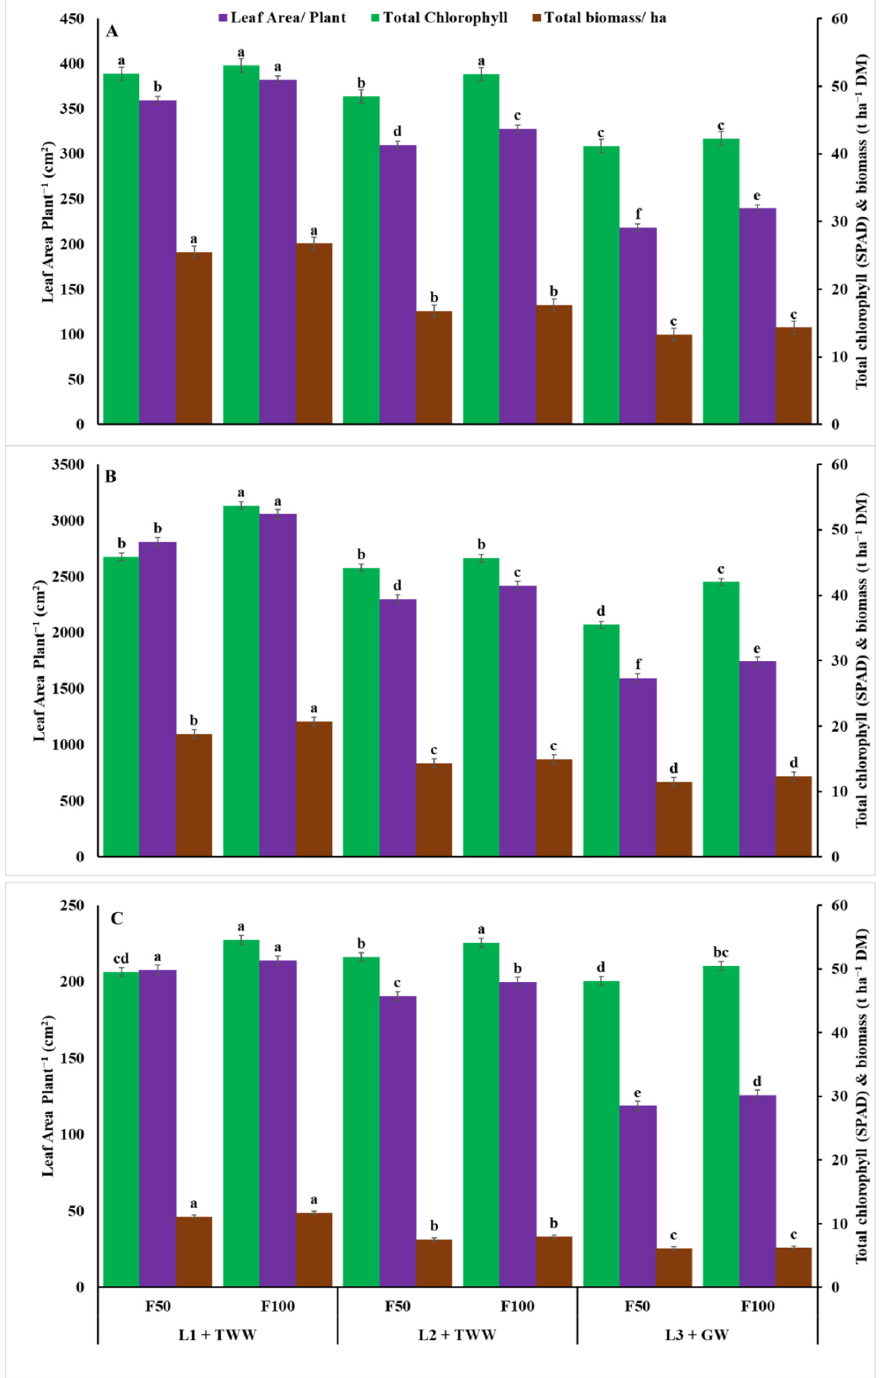
Figure 2. Interaction effects of water resources and fertilization treatments on total chlorophyll, leaf area per plant and total biomass of safflower ( A ), canola ( B ), and triticale ( C ). Old soil with treated wastewater (L1 + TWW), virgin soil with treated wastewater (L2 + TWW), virgin soil with groundwater (L3 + GW), half-dose NPK (F50), full-dose NPK (F100). Values followed by the same letter were not significantly differed for each trait.